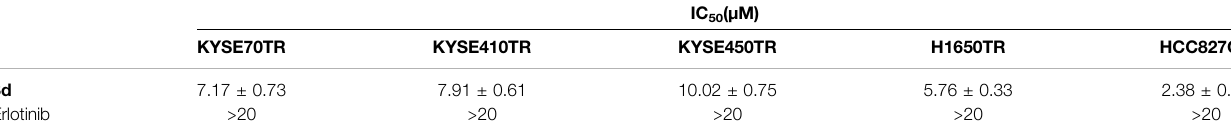
TABLE 4 | Anti-proliferative activities of compounds 3d and erlotinib against drug-resistant cancer cell